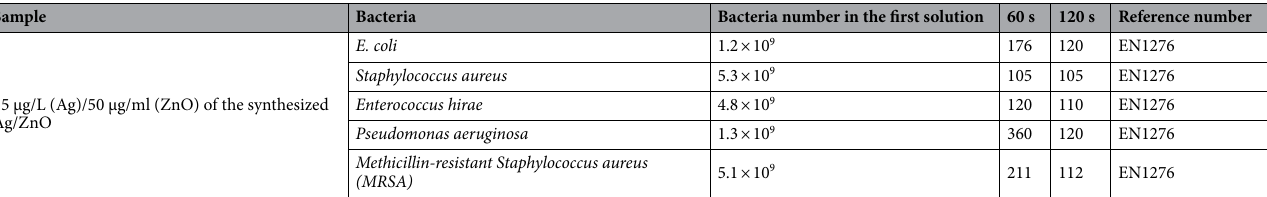
Table 3. The effect of the synthesized nanomaterials on examined